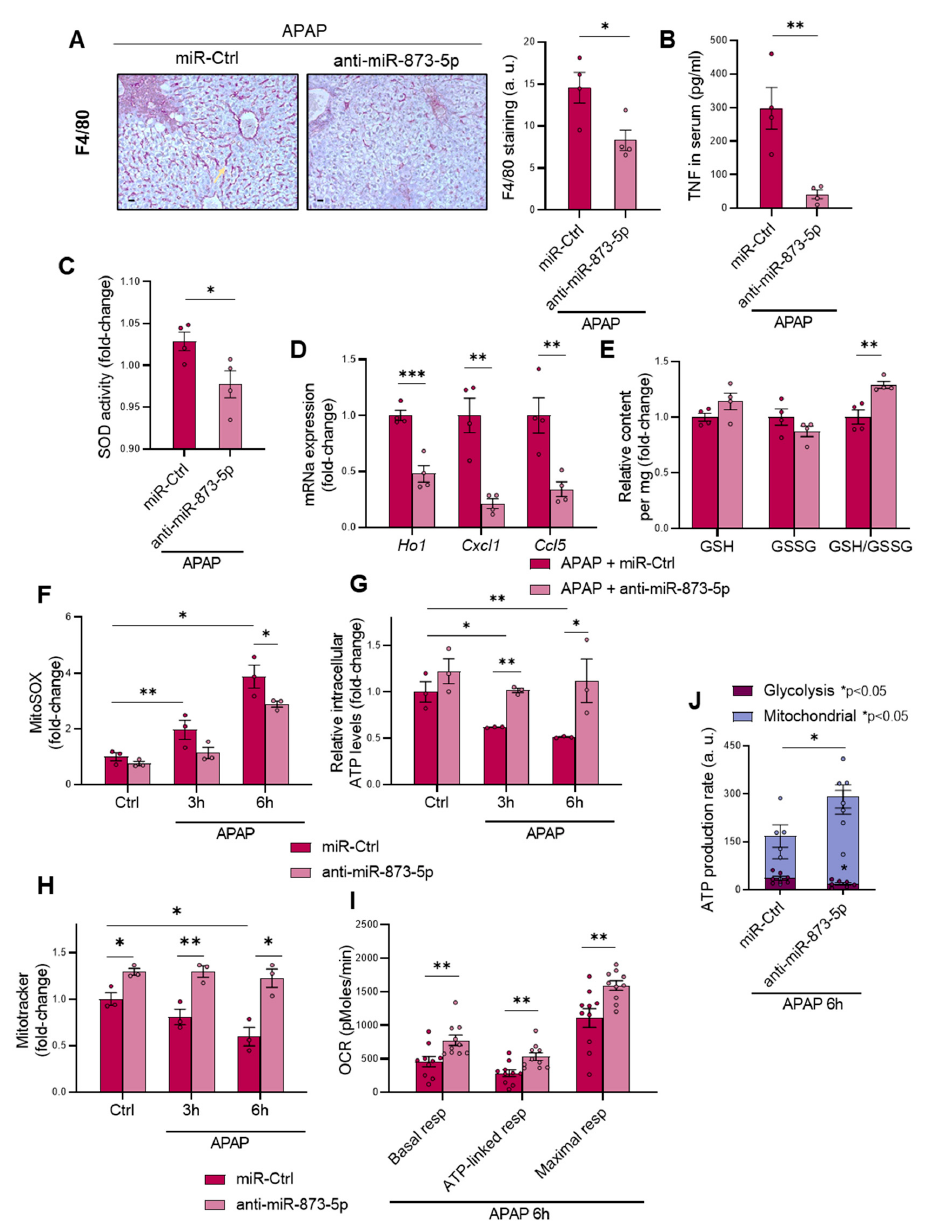
Figure 4. APAP-induced inflammatory response and mitochondrial dysfunction are reduced by the anti-miR-873-5p therapy ( A ) Representative micrographs and respective determination from hepatic F4/80 staining (highlighted with yellow arrows), ( B ) serum levels of tumor necrosis factor (TNF) , ( C ) relative hepatic superoxide dismutase (SOD) activity, ( D ) hepatic mRNA expression of proinflammatory cytokines and ( E ) relative hepatic reduced glutathione (GSH), oxidized glutathione (GSSG) and GSH/GSSG ratio in mice treated with 360 mg/kg acetaminophen (APAP) for 48 h and either anti-miR-873-5p or miR-Ctrl. Scale bar corresponds to 50 μ m. ( F ) Relative mitochondrial ROS staining determination by mitoSOX; ( G ). intracellular ATP levels and ( H ) MitoTracker TM staining determination in primary hepatocytes treated with APAP at 3 and 6 h and either anti-miR-873-5p or miR-Ctrl. ( I ) Oxygen consumption rate (OCR) and ( J ) ATP production from glycolysis and mitochondria in primary hepatocytes upon 6 h APAP stimulation and treated with miR-Ctrl or anti-miR-873-5p. * p < 0.05, ** p < 0.01; *** p < 0.001 are shown. (See also Supplementary Figure